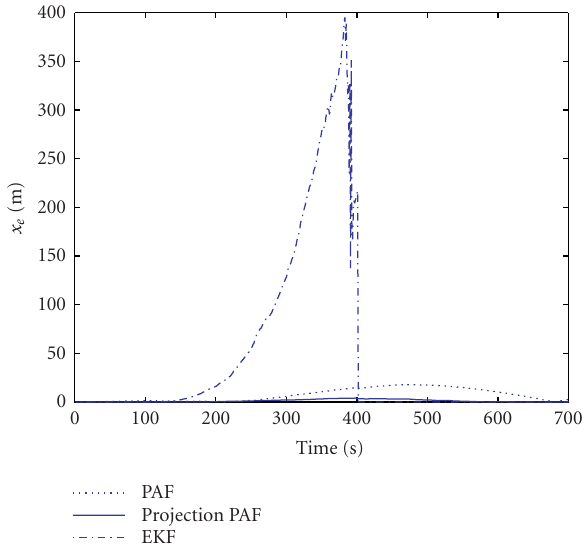
Figure 2: Position estimation error ( = Euclidean distance between Cartesian position vector and its estimate) for three methods: EKF, PAF, and projection PAF. The system starts with six satellites in view. At t = 100 seconds, the signals from three satellites are lost. At t = 400 seconds, the system regains the signal from one satellite.